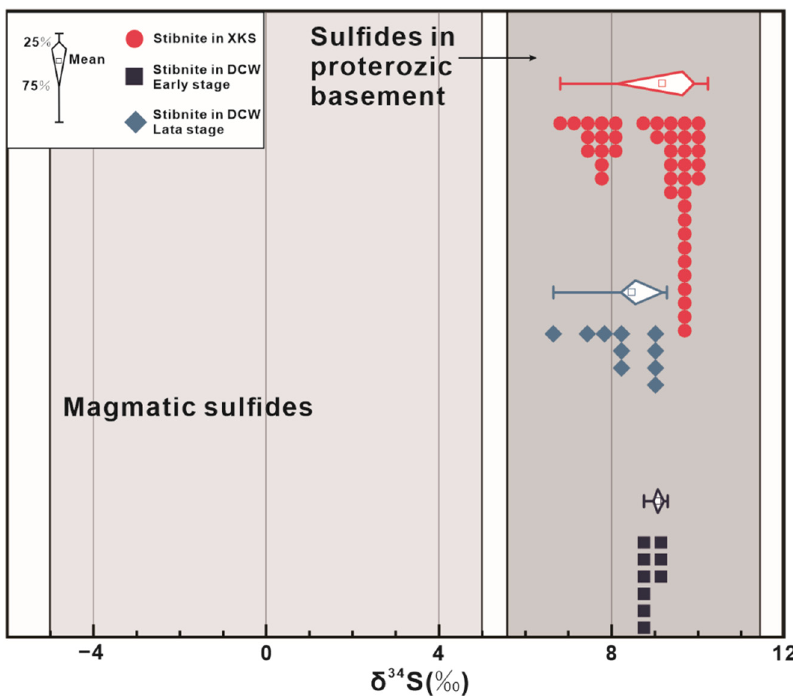
Figure 12. Sulfur isotopic composition of sulfide minerals from the Daocaowan Sb deposit and poten- tial source rocks. Data sources: magmatic sulfides from [58,59]; sulfides in basement metamorphic rocks from [54,60,61]; stibnite in the Xikuangshan from